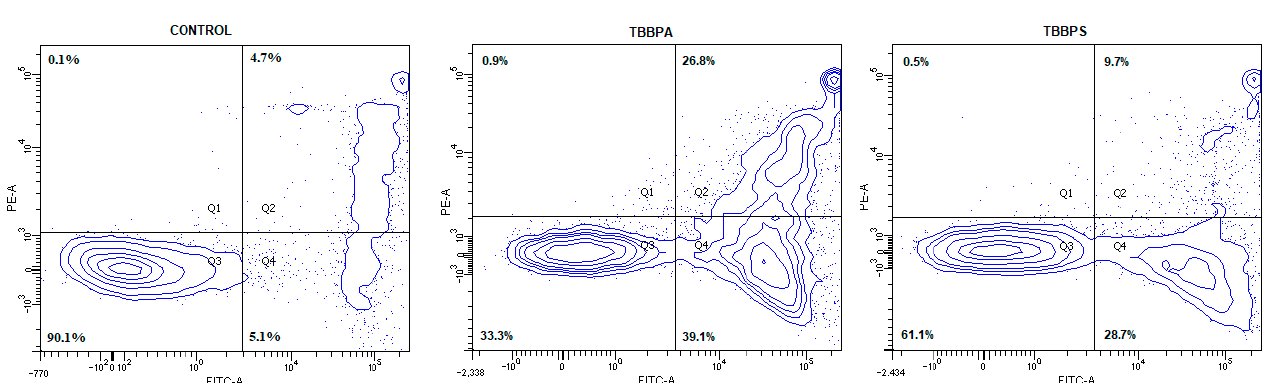
Figure 1. Apoptotic alterations in human PBMCs treated with TBBPA and TBBPS in the range from 1 to 50 µg/mL (n = 4) for 24 h ( A ). The cells were stained with Annexin-FITC and PI. Exemplary dot plots showing apoptotic alterations in human PBMCs unexposed (control) and exposed to TBBPA and TBBPS at 50 µg/mL for 24 h, Q3—live cells, Q2 + Q4—apoptotic cells ( B ). Statistically different from negative control at * p < 0.05. Statistical analysis was conducted using one-way ANOVA and a posteriori Tukey test.